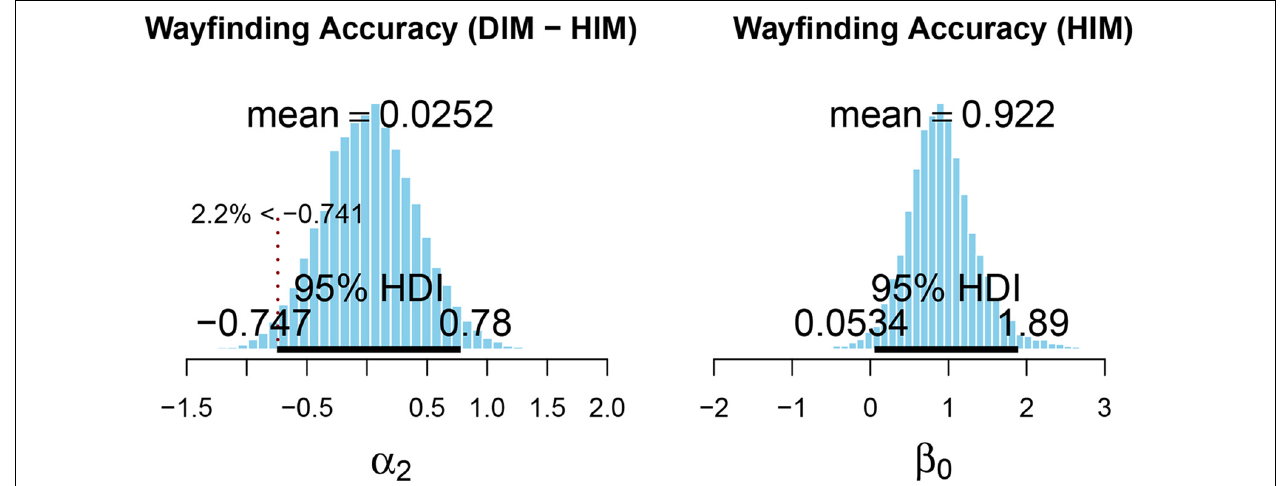
FIGURE 6 | Posterior distribution for the fixed effect (left) and intercept (right) of the model for wayfinding accuracy. The lower limit of the Region of Practical Equivalence (ROPE) is indicated by the dashed vertical line and was set to correspond to − 25% probability (based on the mean of the posterior for β 0 ) of successful wayfinding when using the DIM compared to the HIM. This figure was created using the code provided in DBDA2E-utilities.R (Kruschke, 2014).